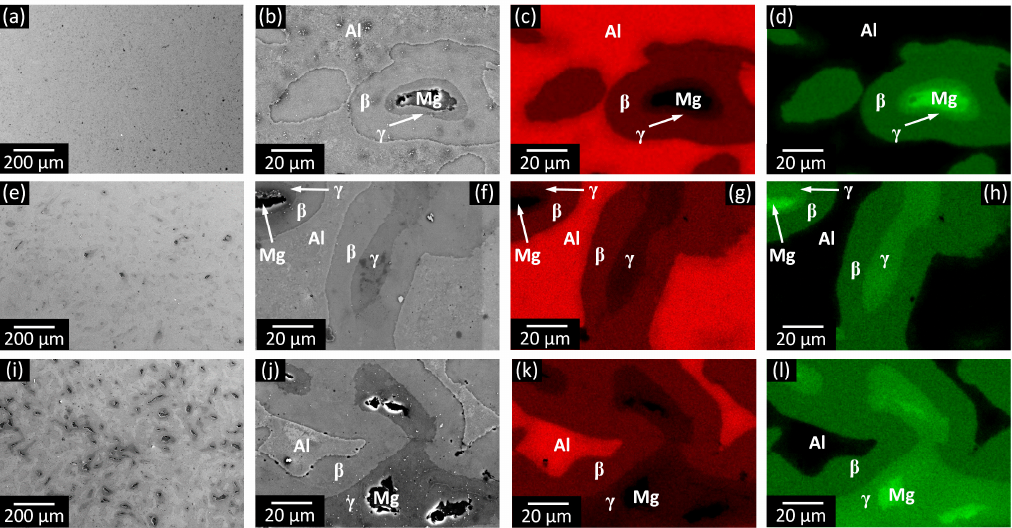
Figure 2. The SEM (scanning electron microscopy) images and EDX (energy dispersive X ‐ ray spectrometry) elemental maps of the Al (red) and Mg (green) distributions for the Al ‐ Mg composites hot ‐ pressed at 673 K with an initial Mg content of ( a–d ) 10, ( e–h ) 20 and ( i–l ) 40 vol %.